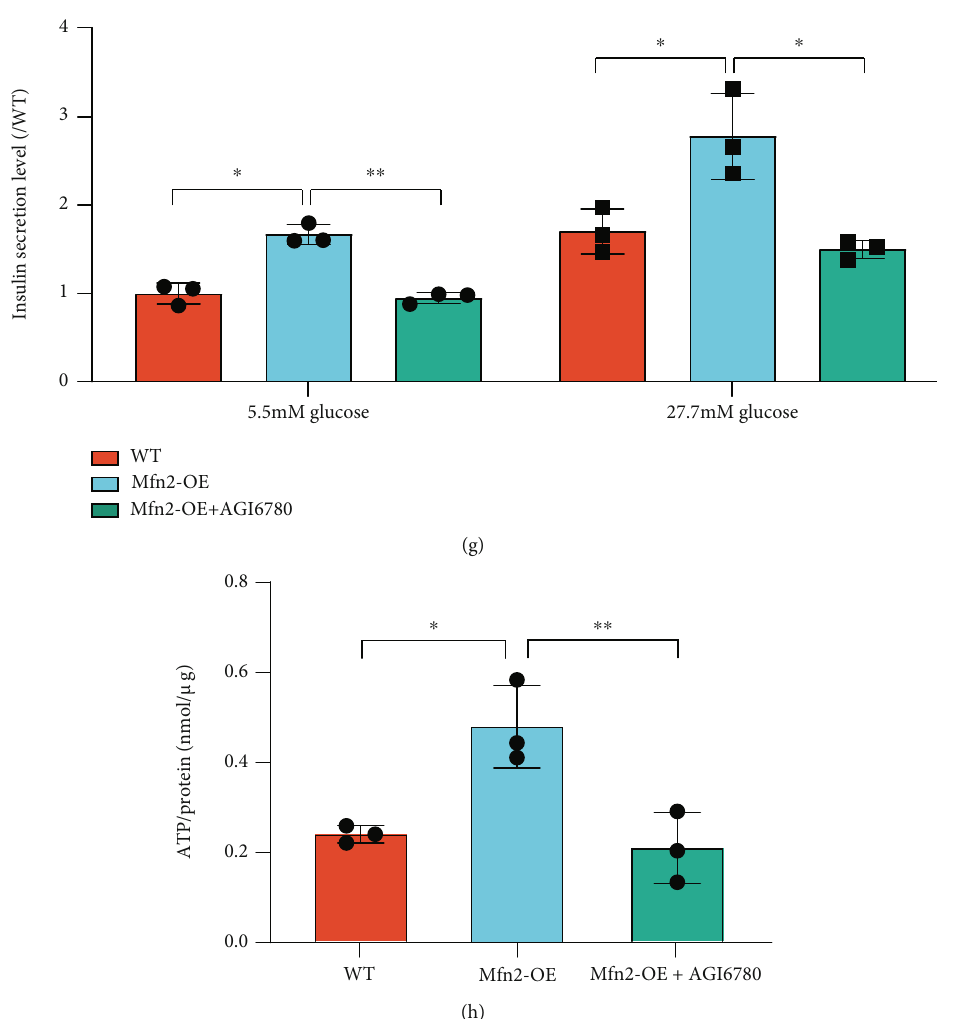
Figure 5: The e ff ects of Mfn2 knockdown and overexpression on Idh2 expression and activation. (a, d) Idh2 mRNA expressions after Mfn2 knockdown (a) or Mfn2 overexpression (d) detected by qRT-PCR. (b, e) Idh2 protein expressions after Mfn2 knockdown (b) or Mfn2 overexpression (e) detected by western blot. (c, f) Idh2 activity after Mfn2 knockdown (c) or Mfn2 overexpression (f) detected by Idh activity assay kit. (g) Insulin secretion level of β cells was measured at termination day of di ff erentiation after Mfn2 overexpression with or without AGI6780 treatment. The insulin secretion level in each group was normalized to the insulin secretion level of WT cells stimulated with 5.5mmol/L glucose. (h) ATP production on day 5 + 28 after one-hour 2.5mmol/L glucose stimulation. The ATP levels were compared to the total protein amount. n = 3 . Values represent mean ± S : D . Statistical signi fi cance was set as ∗ P < 0 : 05 and ∗∗ P < 0 : 01 . Student ’ s t -test for (a – f); one-way ANOVA for (h); two-way ANOVA for